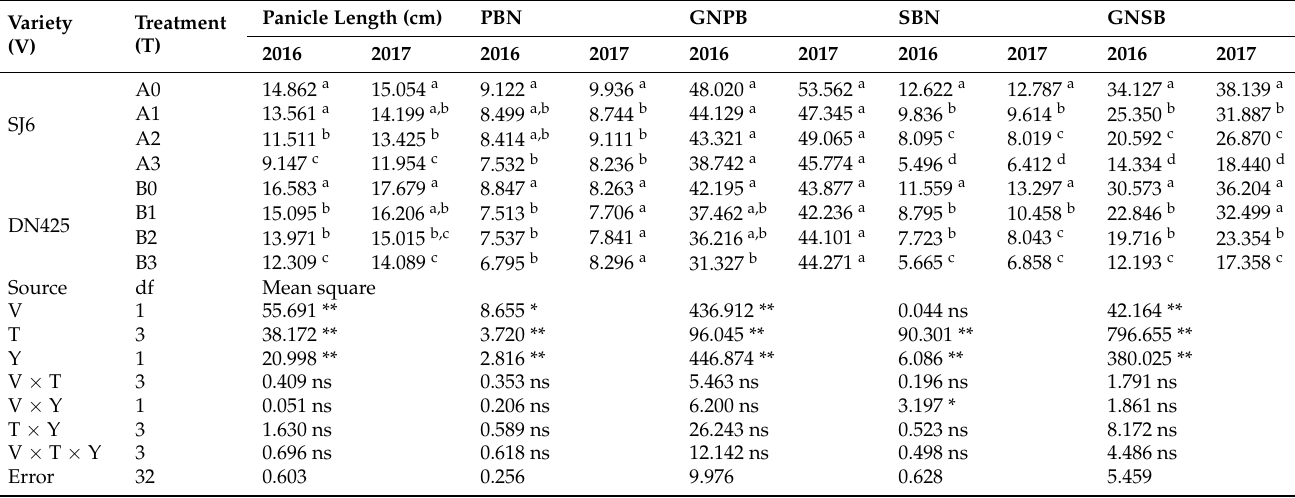
Table 3. Effects of drought stress at the jointing–booting stage on the panicle characters of growth period overlapping rice in 2016 and